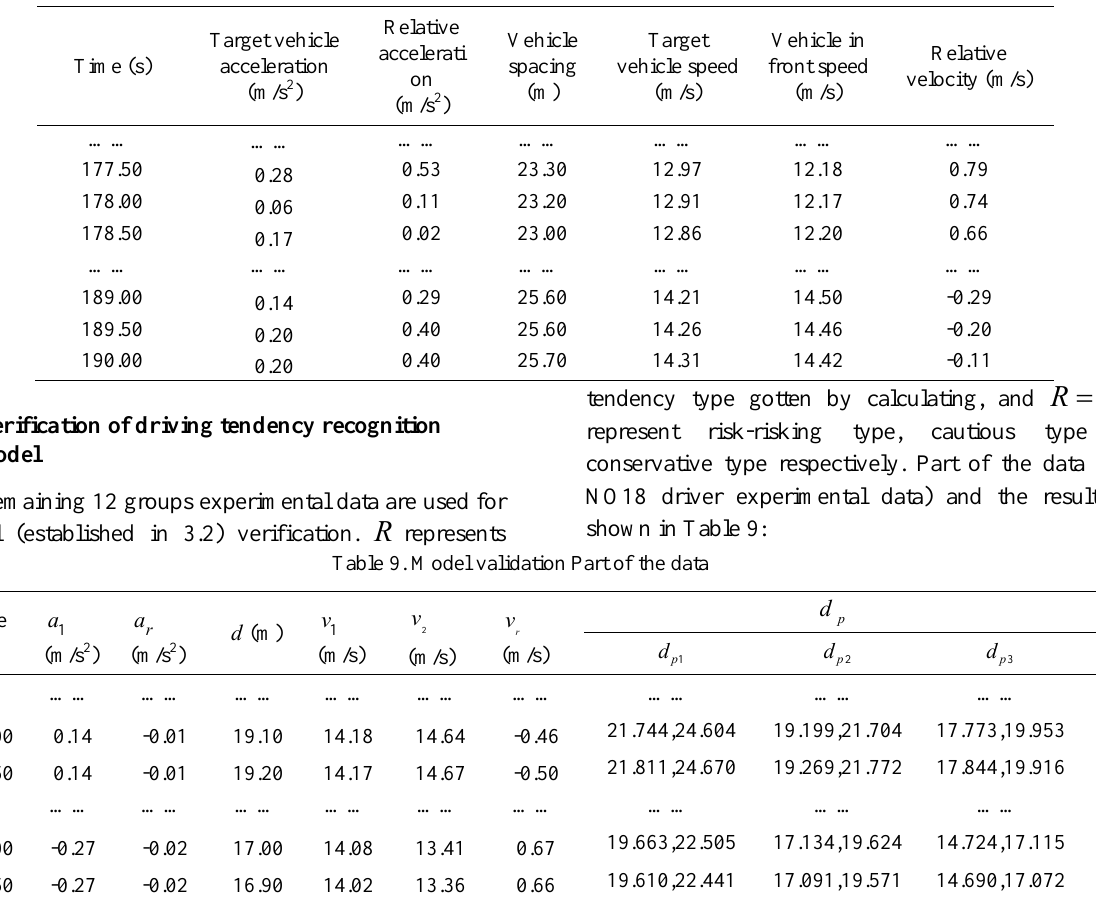
Table 8. Conservative type driver part of the experimental data